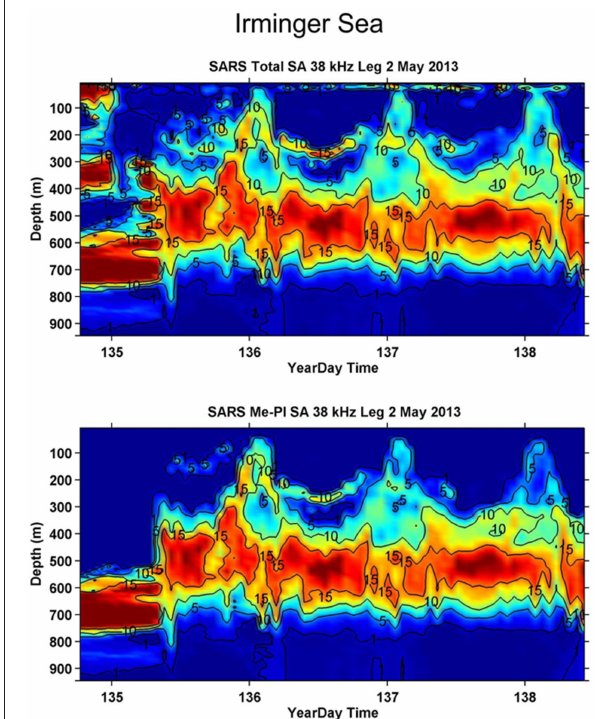
FIGURE 2 | Echograms from the Norwegian Euro-Basin cruise in May 2013, characterizing the distribution of the total backscatter, Sa values; see annotations (MacLennan et al., 2002), (upper panel) and the backscatter attributed to mesopelagic organisms (lower panel) at 38kHz in the Irminger Sea, from Melle (2013). The diel vertical migration pattern of the community is clearly visible. The data has been processed according to standard IMR procedures using LSSS (Korneliussen et al.,